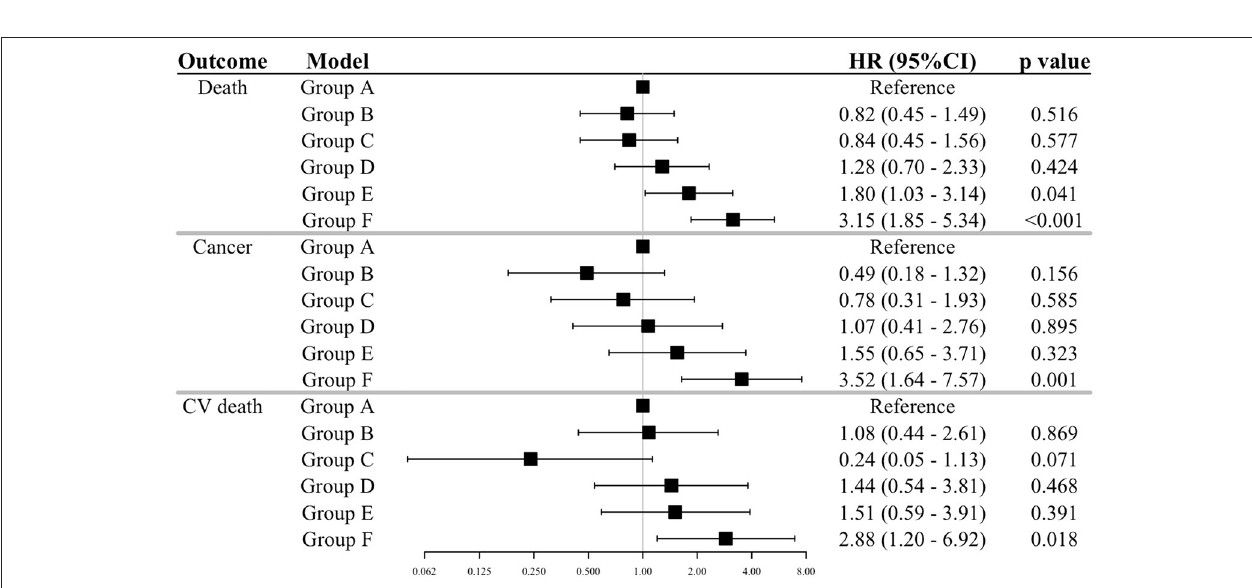
FIGURE 3 | Relations of the GDF-15/BMI-based groups to outcomes. The results of a Cox proportion hazard analysis by the GDF-15/BMI-based group outcomes adjusted for traditional risk factors are shown. The GDF-15/BMI-based groups were as defined in Figure 2 . Adjustments of the Cox model are as shown in Figure 1 . GDF-15, growth differentiation factor-15; BMI, body mass index; CV death, cardiovascular death.